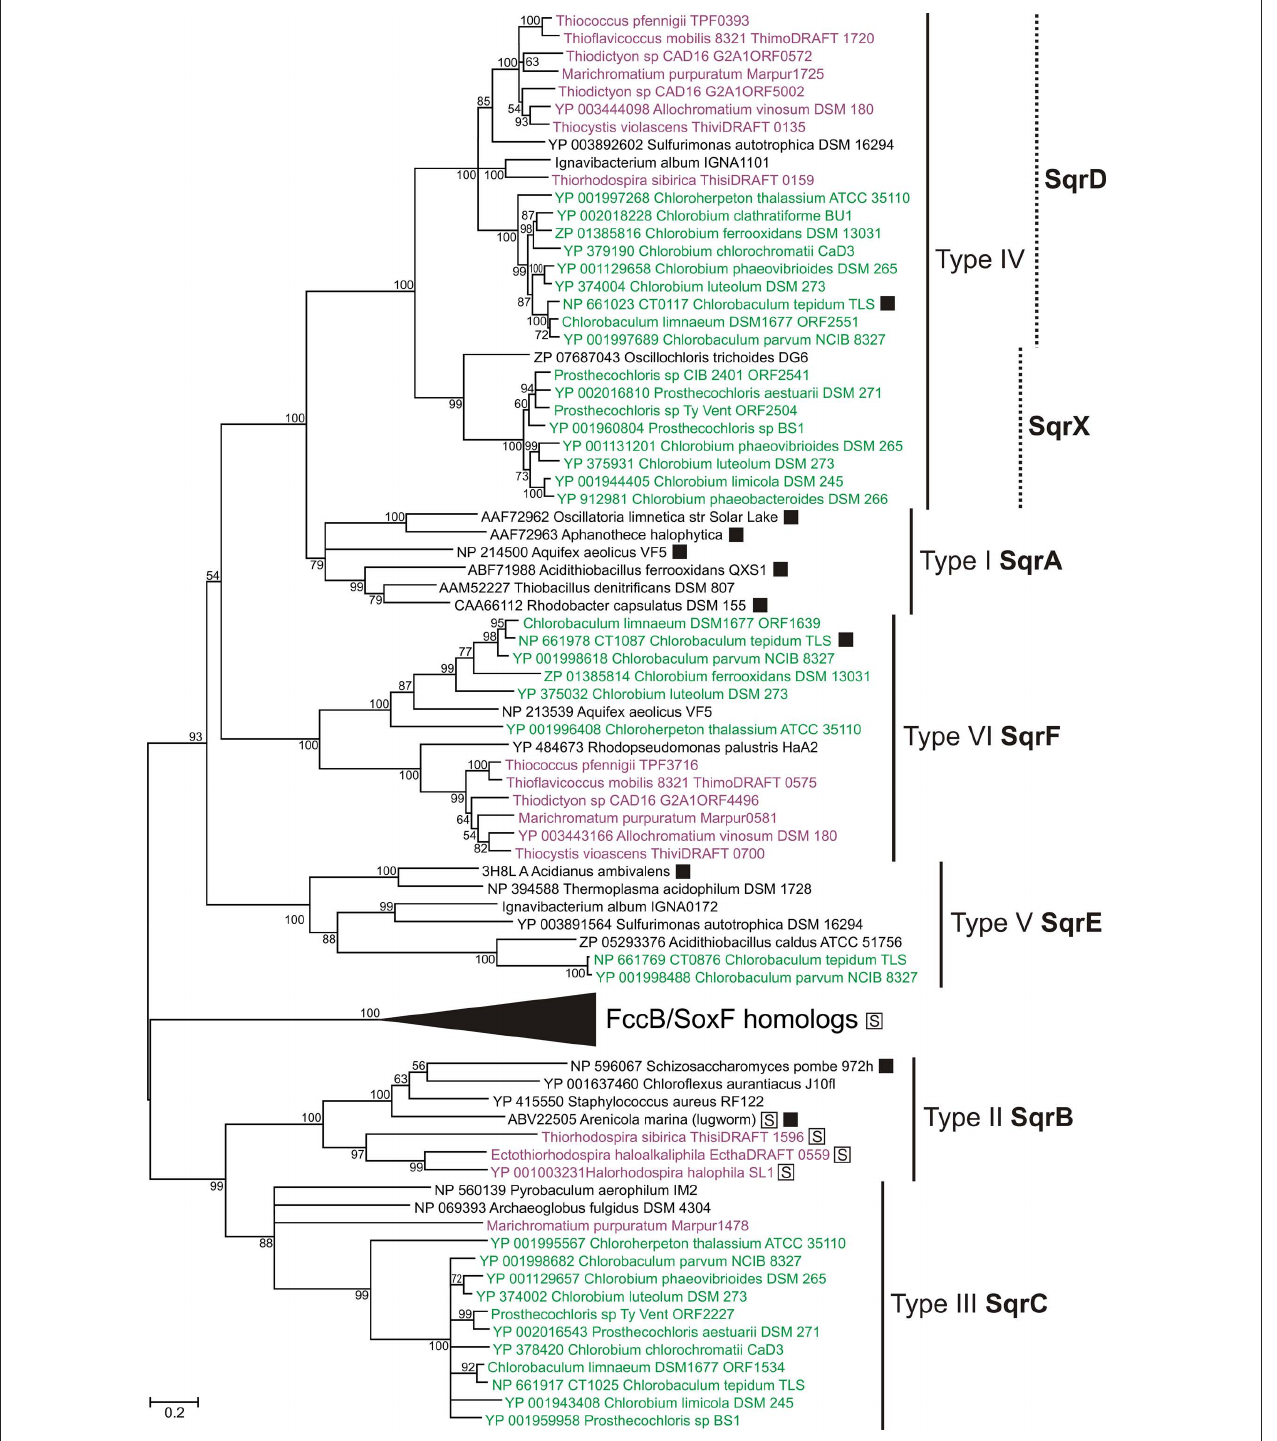
Figure 3 | Phylogenetic tree of sulfide:quinone oxidoreductase (SQr) homologs. Tree construction details were as in Figure 2 , except that the tree is unrooted. The clade of FccB/SoxF homologs is expanded in Figure 4A . SQR activity has been demonstrated for proteins marked with a filled box. Proteins marked with a boxed “S” had a signal peptide. All proteins in the FccB/SoxF homologs clade (see Figure 4A ) and proteins from PSB in the